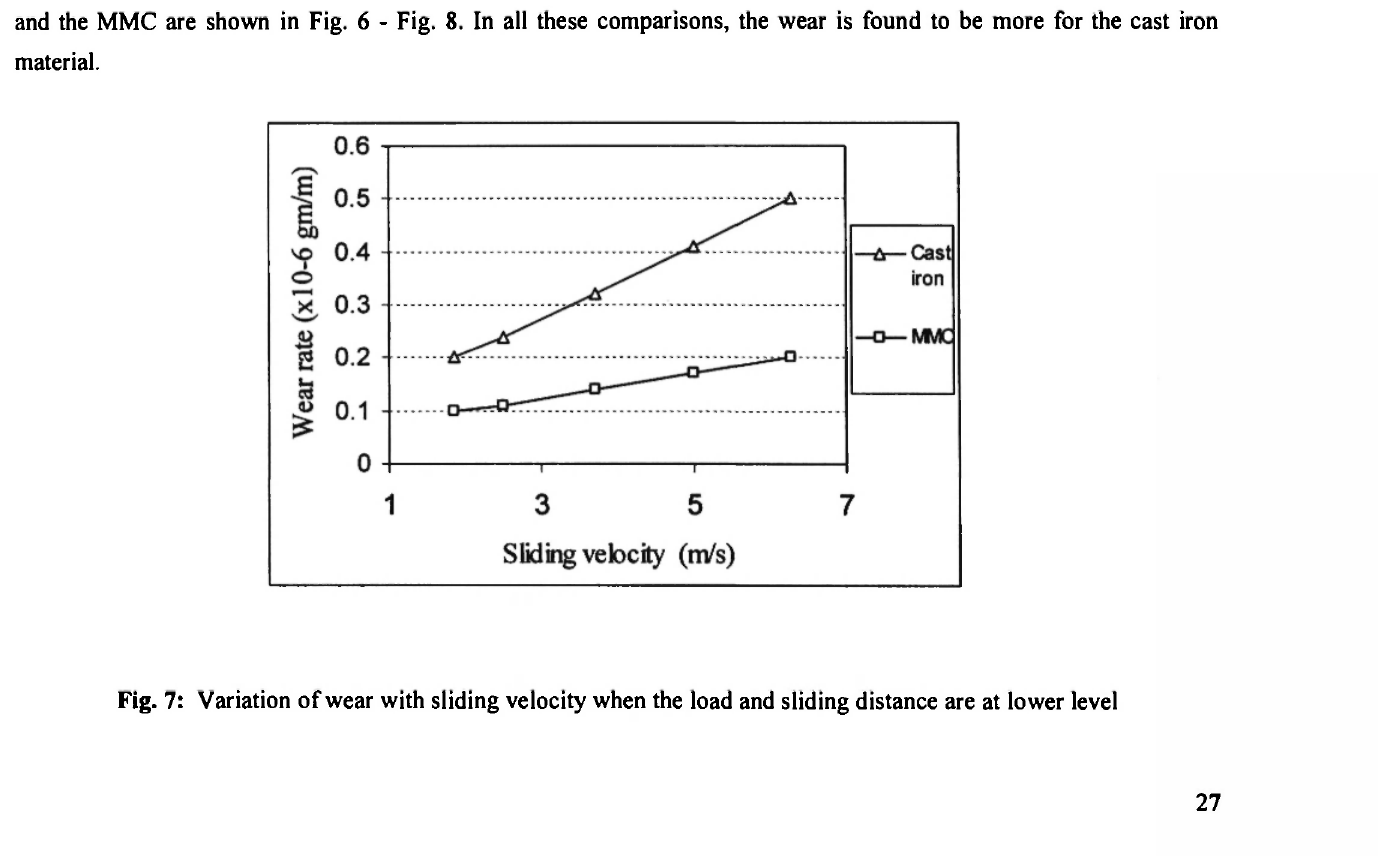
Fig. 7: Variation of wear with sliding velocity when the load and sliding distance are at lower